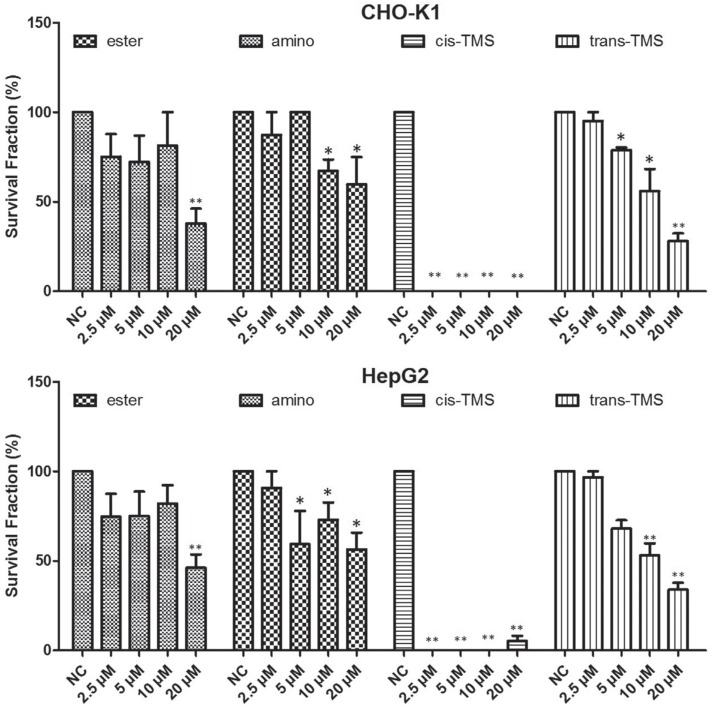
Clonogenic assay showing the survival fraction of CHO-K1 and HepG2 cell lines after 24 h treatment with different concentrations of ester, amino, cis-TMS and trans-TMS stilbenes. Cells were treated for 24 h and allowed to grow during seven consecutive days. NC: negative control. *p < 0.05 and **p < 0.01 compared to negative control.